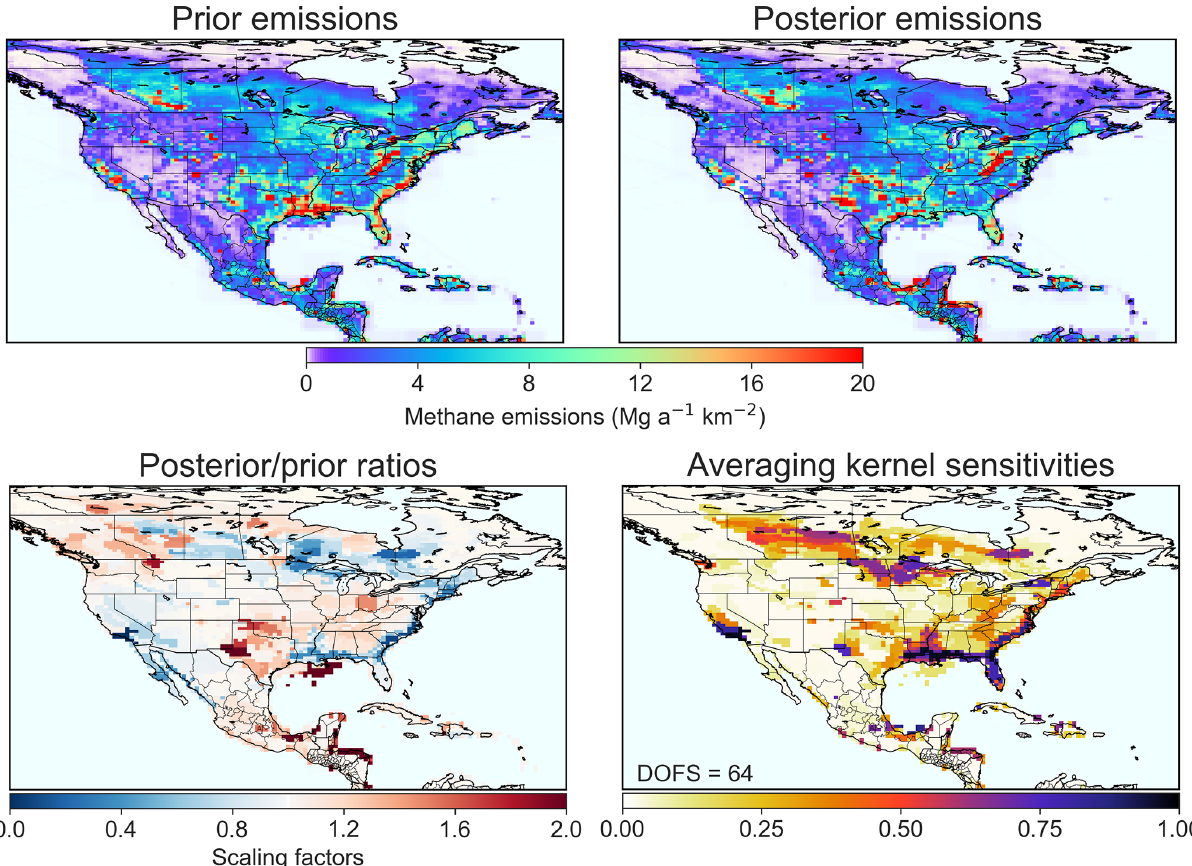
Figure 3. Mean 2010–2015 posterior methane emissions projected from the 600-member Gaussian mixture to the 0 . 5 ◦ × 0 . 625 ◦ model grid and comparison to the prior estimate. Results are from the base inversion. The bottom right panel shows the averaging kernel sensitivities projected to the model grid (diagonal elements of the averaging kernel matrix). The trace of the averaging kernel matrix, i.e., the degrees of freedom for signal (DOFSs), is given inset. It represents the number of independent pieces of information that can be constrained by the